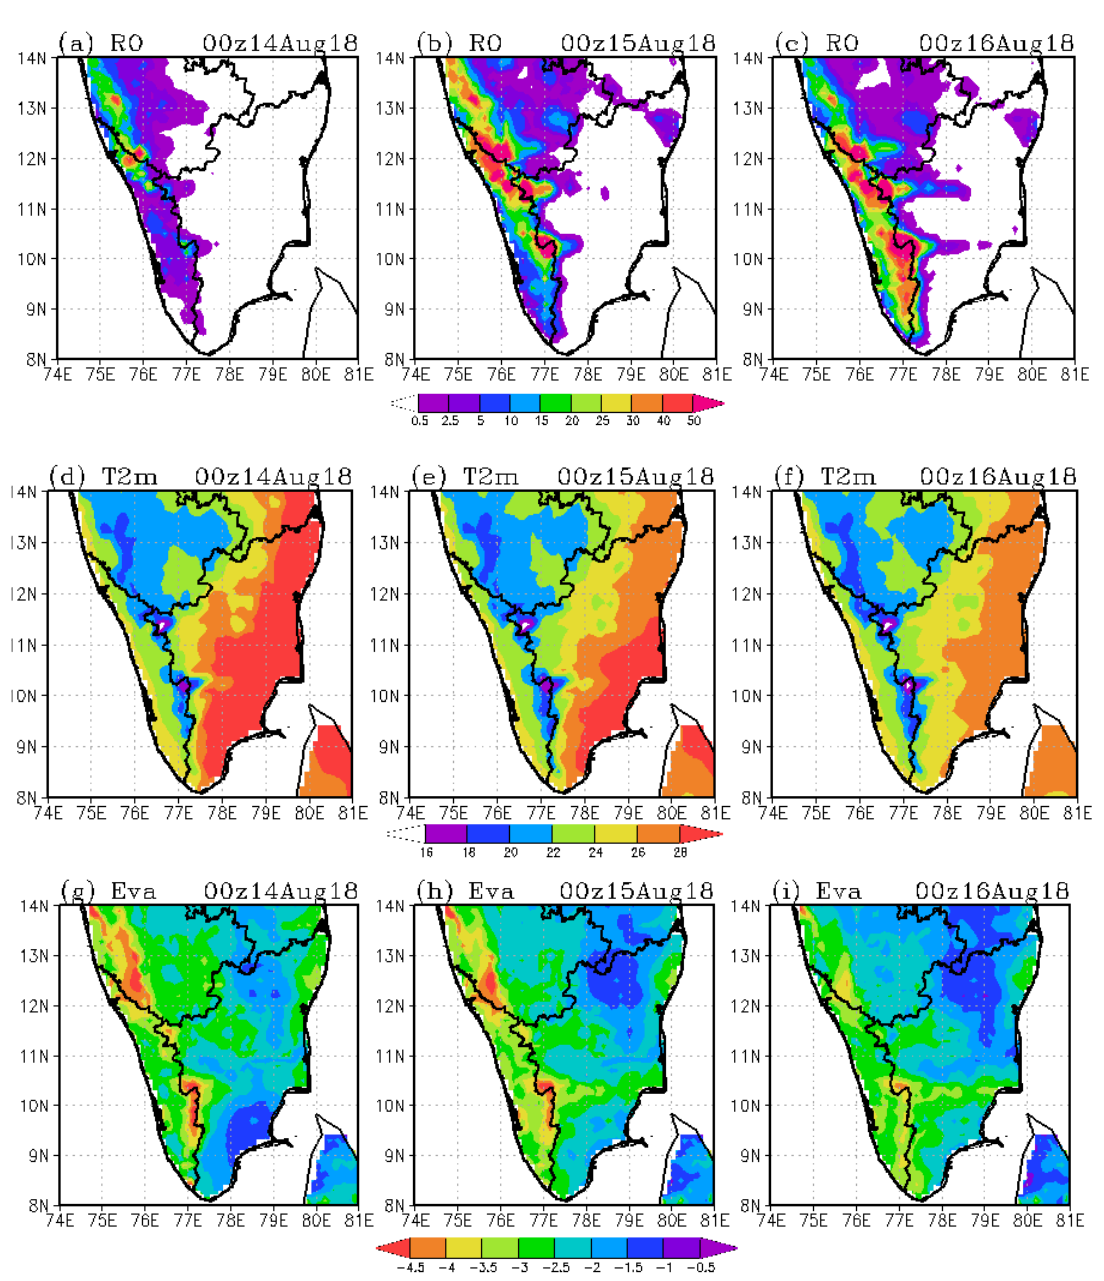
Figure 6. Total surface runoff (mm·d − 1 ) distributions over the Kerala land region valid at 00 UTC on ( a ) 14 August, ( b ) 15 August, and ( c ) 16 August 2018 derived from ERA-Interim reanalysis at 25 km resolutions; both Figure ( d – f ) and ( g – i ) are the same as ( a – c ), but for temperature (°C) and evaporation (mm·d − 1 ), respectively.